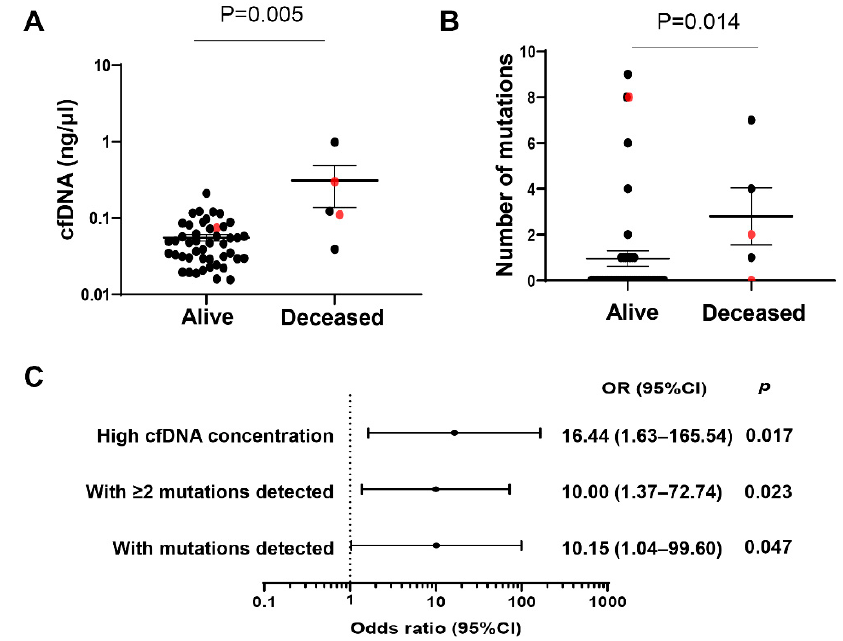
Figure 4. Mutations identified in cfDNA from Hispanic subjects with APRI ≥ 1 correlate with an outcome of death. ( A ) cfDNA concentration in Hispanic subjects with APRI ≥ 1 between alive and deceased. ( B ) Number of mutations detected in cfDNA in Hispanic subjects with APRI ≥ 1 between alive and deceased. Data are presented as mean ± SEM. Subjects with liver cancer are annotated in red. ( C ) Forest plot of significant associations between being deceased and high cfDNA concentration (quartile Q4) and number of mutations among subjects with APRI ≥ 1. APRI, Aspartate transaminase to Platelet Ratio Index; OR, odds ratio; CI, confidence interval.